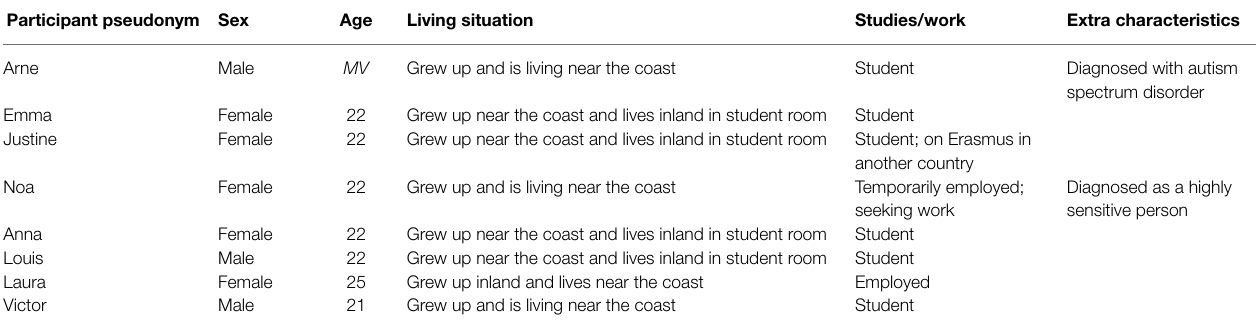
TABLE 1 | Participant characteristics.